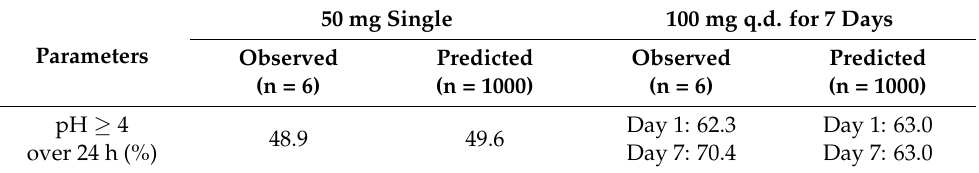
Table 6. The observed and predicted time of pH ≥ 4 over 24 h after single or repeated administrations of